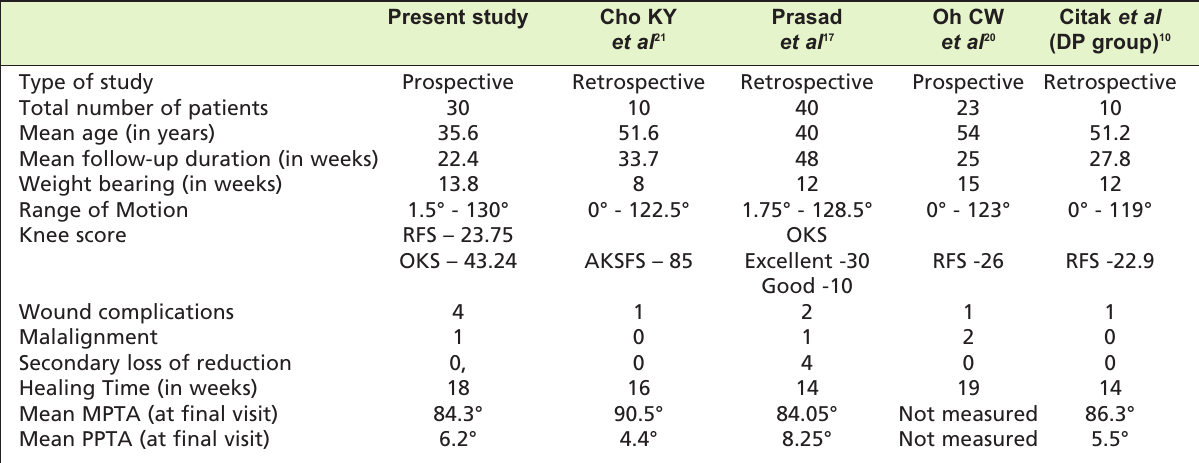
Comparison between the present study and other studies Table V: Present